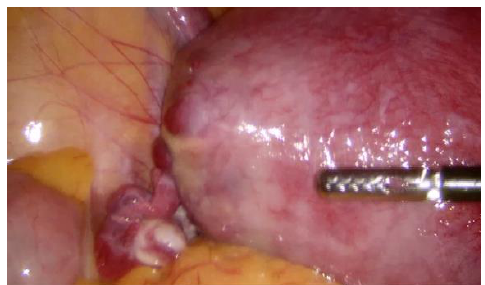
Figure 3. Left cornu of the uterus, observed during diagnostic laparoscopy.